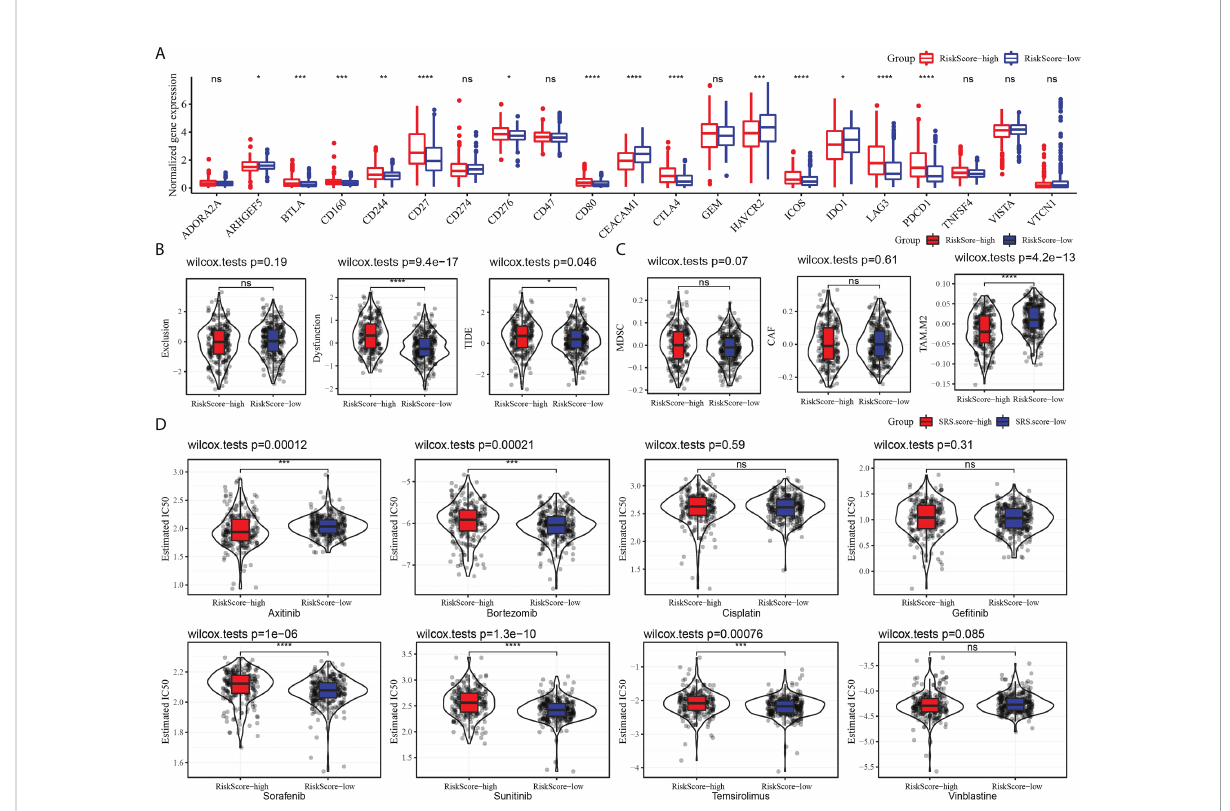
FIGURE 9 Risk model predicted response to immunotherapy and chemotherapy. (A) The level of 21 immune checkpoints in the high-risk subgroup and low-risk subgroup. (B) The relationship between risk score and tumor immune exclusion, tumor immune dysfunction, and TIDE. (C) Association of risk score with chemotherapy-resistant cells MDSC, CAF, and M2 TAM. (D) Sensitivity of eight types of chemotherapeutic drugs in high-risk and low-risk subgroups. * P < 0.05, ** P < 0.01, *** P < 0.001, **** P < 0.0001, ns, not signi fi